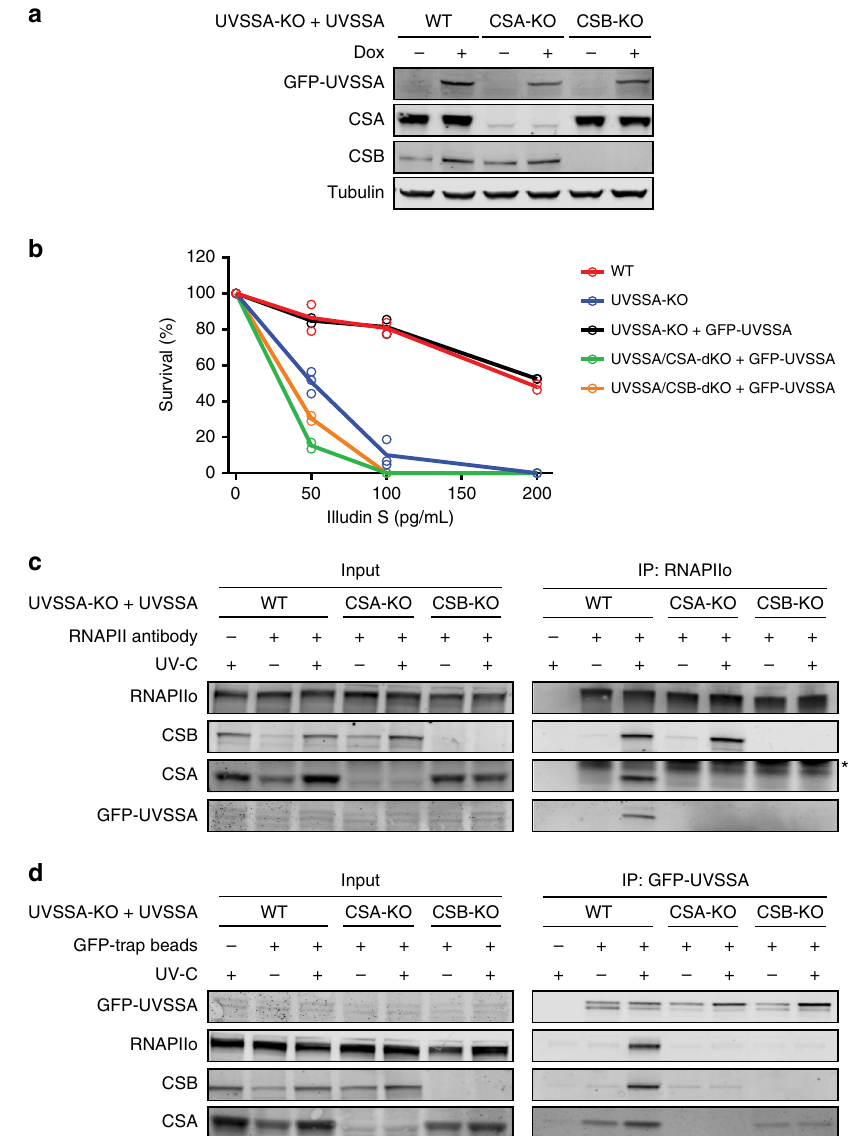
Fig. 4 UVSSA is recruited to DNA damage-stalled RNAPIIo by CSA. a Western blot analysis of UVSSA-KO, UVSSA/CSA-dKO, and UVSSA/CSB-dKO complemented with GFP-UVSSA ( n = 2). b Clonogenic Illudin S survival of WT, UVSSA-KO, UVSSA/CSA-dKO, and UVSSA/CSB-dKO cell lines complemented with GFP-UVSSA. Each symbol represents the mean of an independent experiment ( n = 2 for all except for UVSSA-KO which is n = 3), each of which is based on two technical replicates. c Endogenous RNAPII Co-IP on UVSSA-KO, UVSSA/CSA-dKO, and UVSSA/CSB-dKO complemented with GFP-UVSSA. d Co-IP of GFP-UVSSA in UVSSA-KO, UVSSA/CSA-dKO, and UVSSA/CSB-dKO cell lines. The asterisk in c indicates the heavy chain of the RNAPII antibody. At least two independent replicates of each IP experiment were performed obtaining similar results. Source data are provided as a Source Data fi